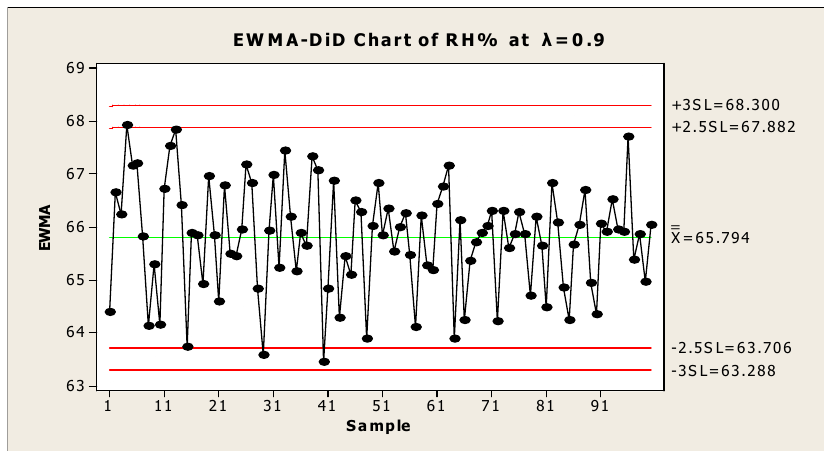
Figure 16. EWMA-DiD Chart of RH% at λ = 0.40.